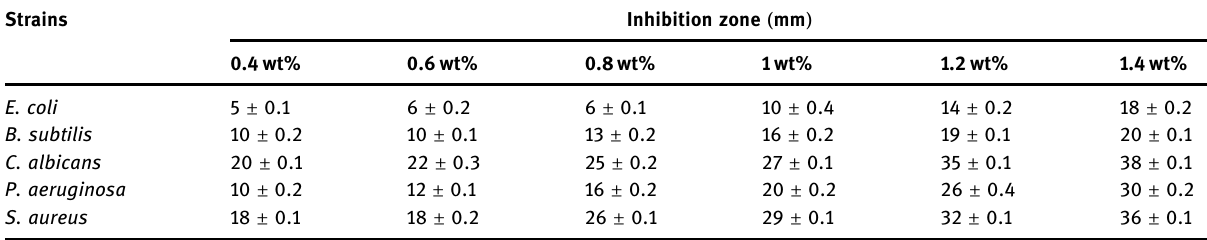
Table 3: In fl uence of di ff erent concentrations of ZnO - NPs in the matrix of ( PVP:CMC ) /CA/G fi lms on the growth of di ff erent microbial strains Strains Inhibition zone ( mm